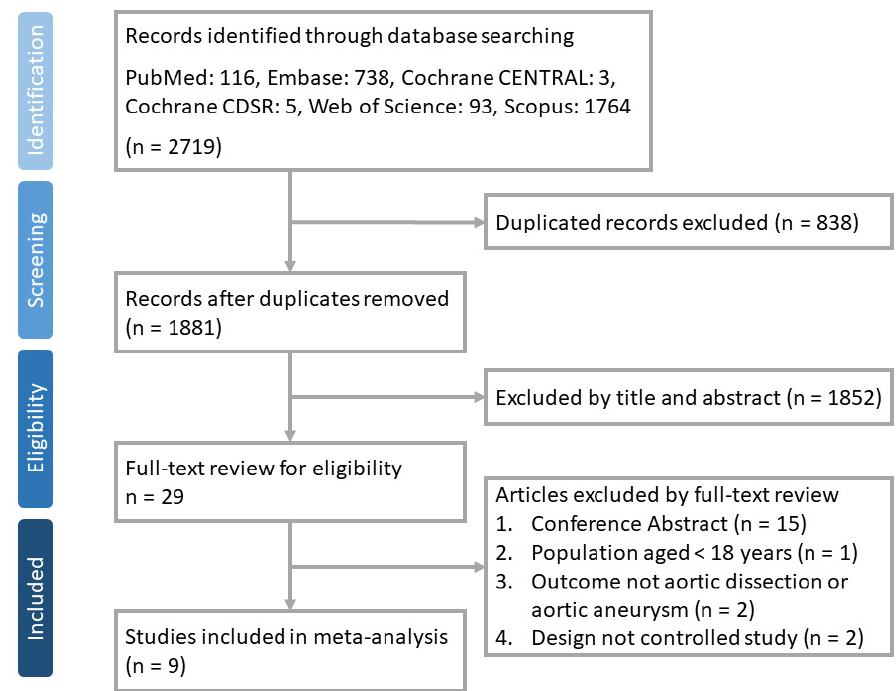
Figure 1. Flow chart of study selection.